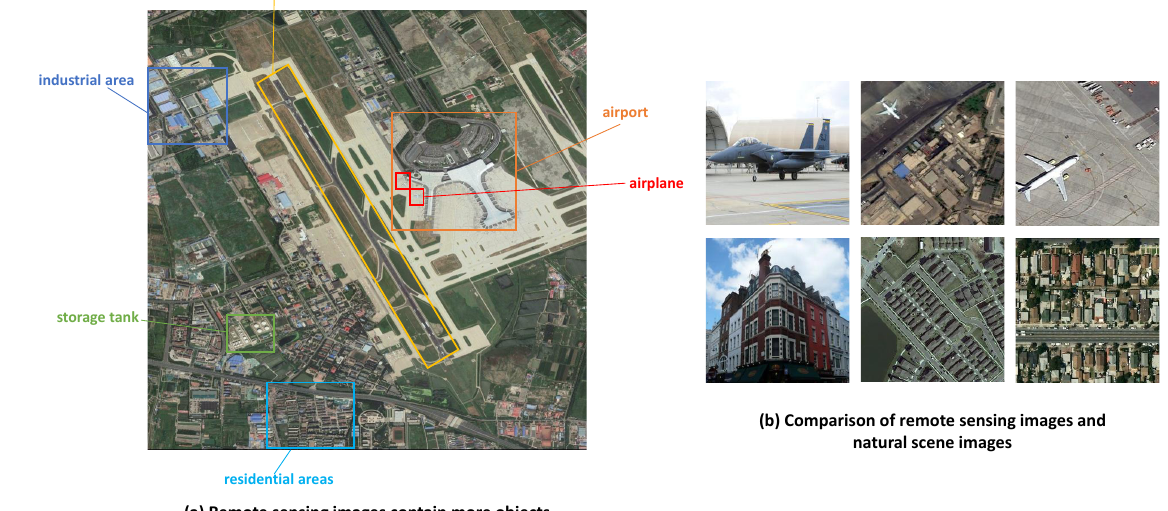
Figure 1. Comparison of remote-sensing images and natural images.